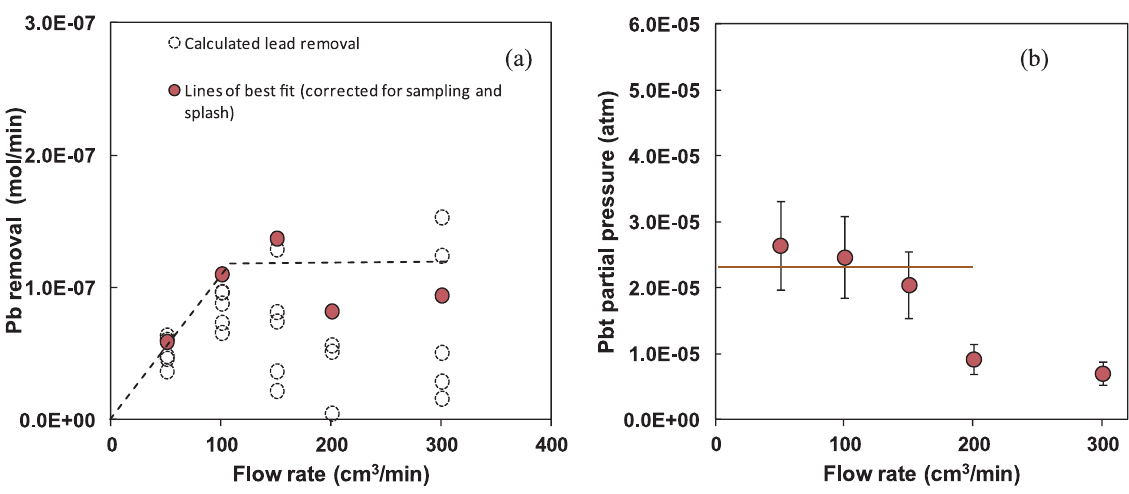
Fig. 3: Comparing the Pb removal rate of a 50 wt% Cu matte containing 100 Pb at 1300 °C bubbled with Ar at flow rates between 50 and 300 cm 3 .min − 1 . (a) Lead removal rate expressed as mol.min − 1 from 100 g of copper matte from individual sampling intervals and from the lines of best fit; (b) The total lead partial pressure in the gas as a function of the gas flow rate, excluding the 200 cm 3 .min − 1